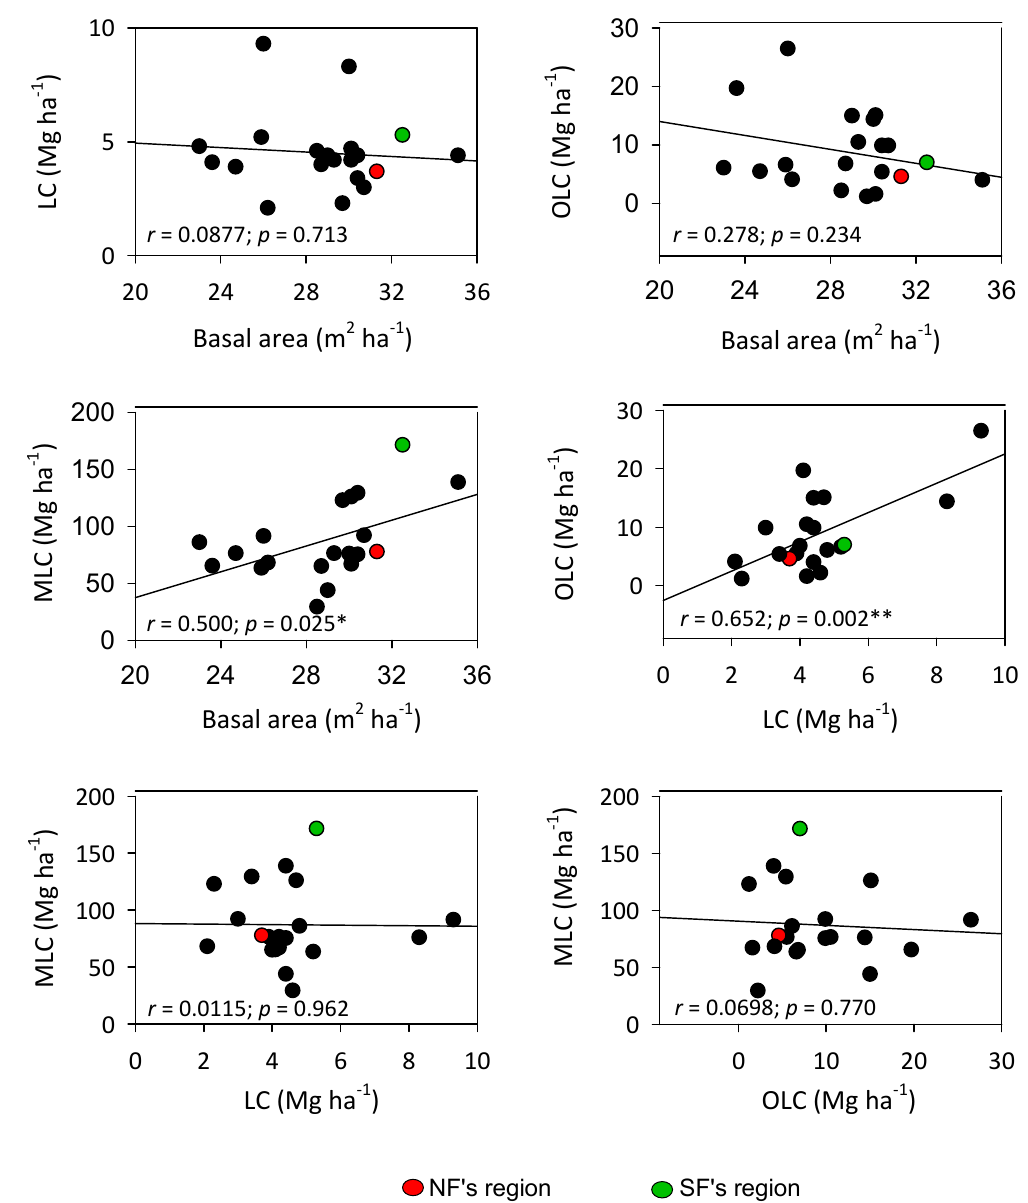
Figure 8. Relationships among C pools in litter (LC), organic layer (OLC) and mineral soil (MLC) and between basal area and C pools in Italian beech forests. Points are mean estimates for the twenty administrative regions, reported in the National Forest Inventory (website “inventarioforestale.org”). Points in color refer to the two regions where the forests investigated in this paper are located.